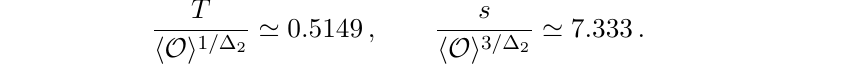
or as the limit (cid:30) H ! (cid:30) (cid:0) c c